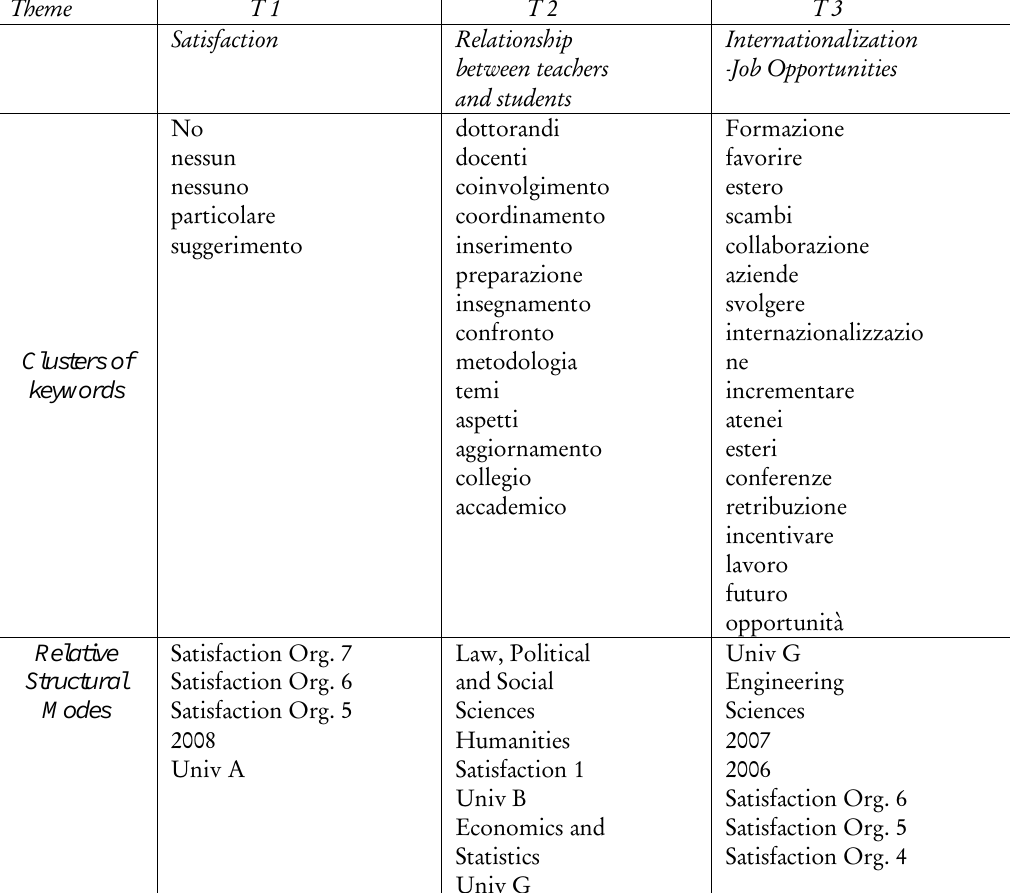
Semantic groups with relative structural